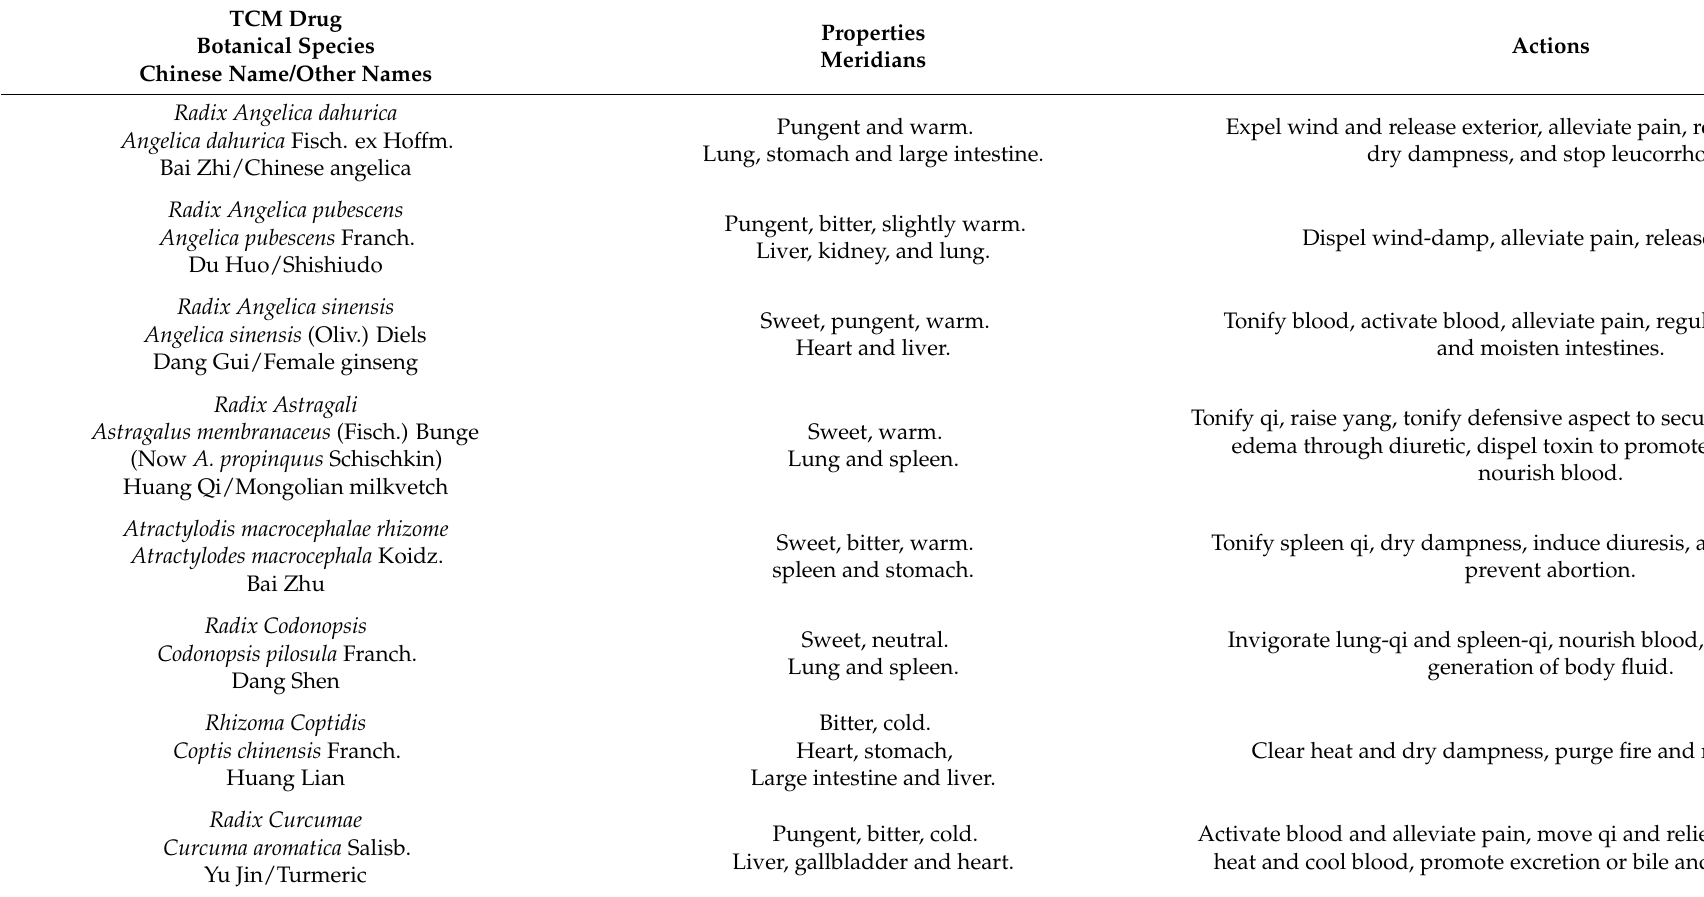
Table 1. Scientific, pharmacopeial and Chinese names of the selected herbal drugs and their properties and actions according to the traditional Chinese medicinal system